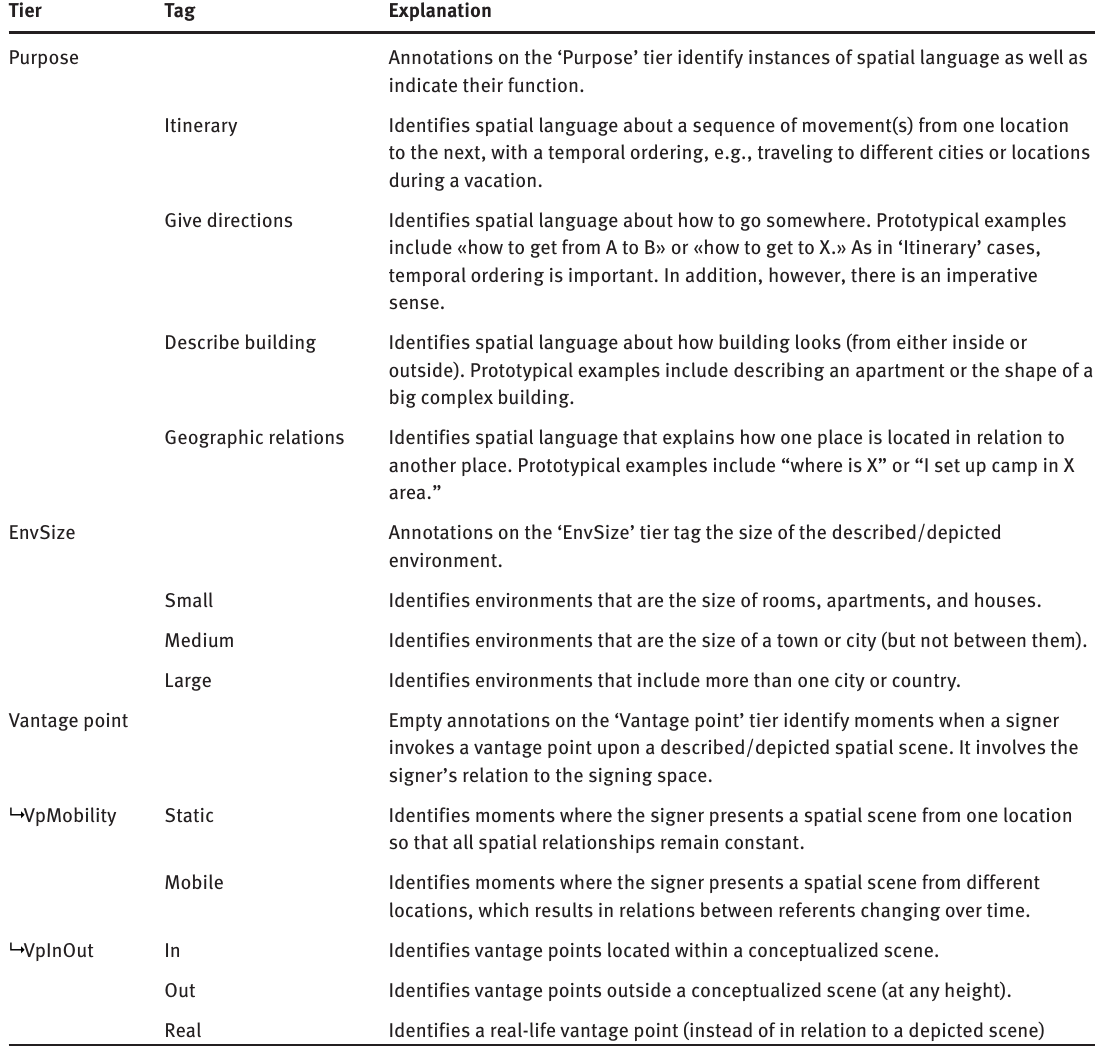
Table 2: Tiers and tags used to annotate the description of spatial scenes.